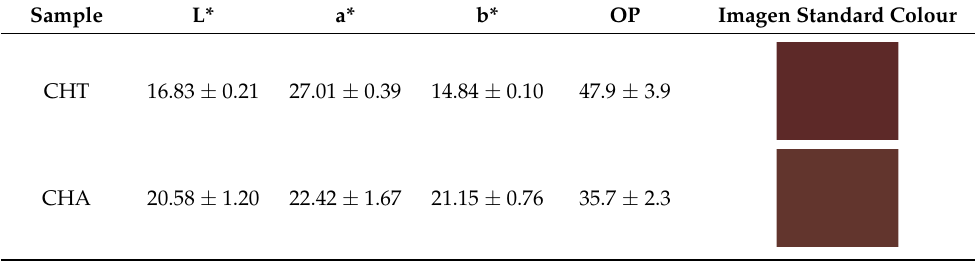
Table 5. CieLab data of the chañar films.